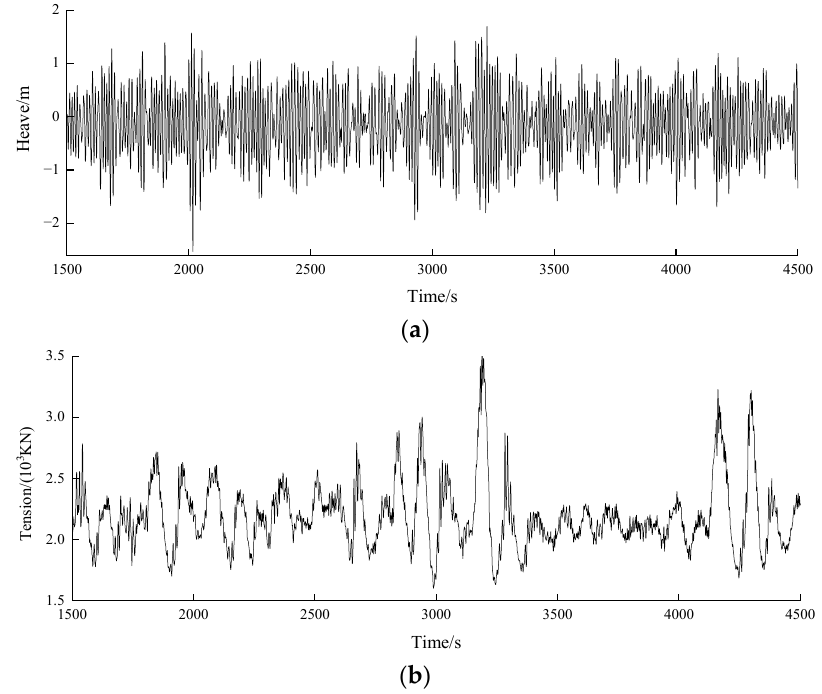
Figure 7. Part of simulated results in sea state 7. ( a ) The heave motion of platform in sea state 7; ( b ) the top tension of line #1 in sea state 7.